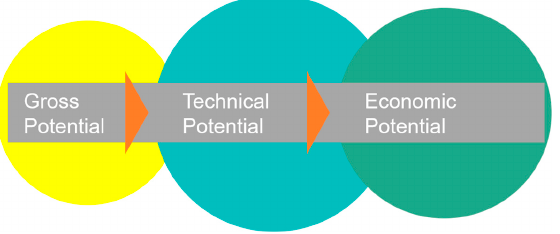
Figure 2. Diagram of correlation between solar energy potentials for big cities with high multilevel buildings.